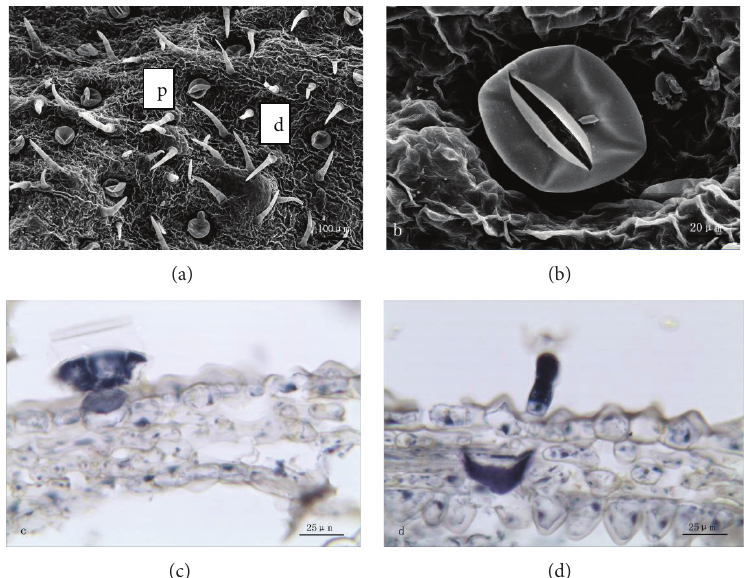
Figure 6: ((a), (b)) SEM micrographs showing the morphology of glandular trichomes on outer side of corolla of T. quinquecostatus. (a) Peltate trichomes (p) and digitiform ones (d). (b) A peltate trichome. ((c), (d)) Transverse sections of T. quinquecostatus corolla. (c) A peltate trichome. (d) A digitiform